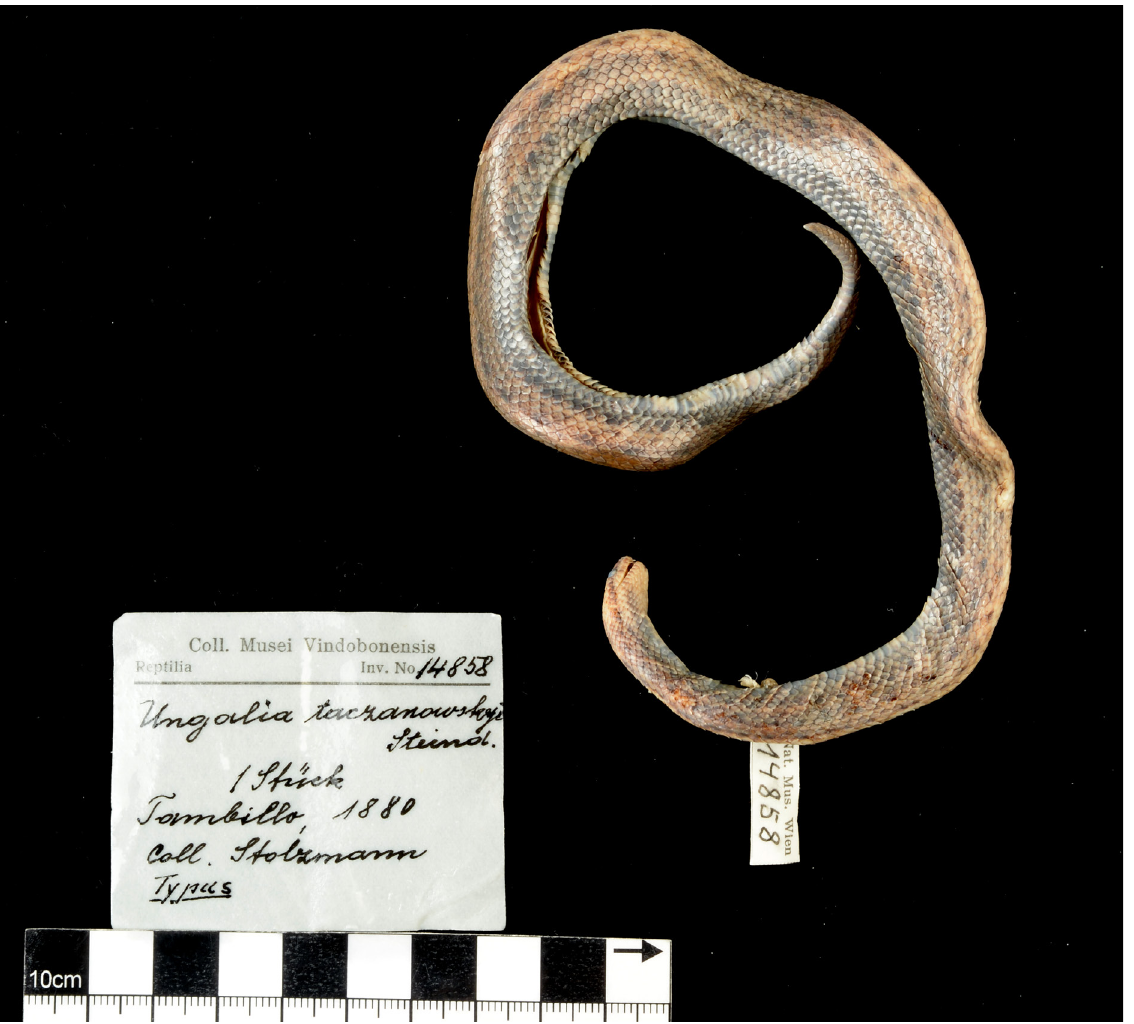
Fig. 15. Lectotype of Tropidophis taczanowskyi (Steindachner, 1880) (NMW 14858) from Tambillo, Peru. Note its conspicuous keeled dorsal scales and striped dorsolateral pattern. Photograph credit: Georg